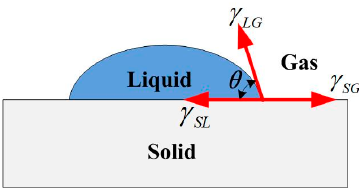
Figure 6. Illustration of the contact angle.